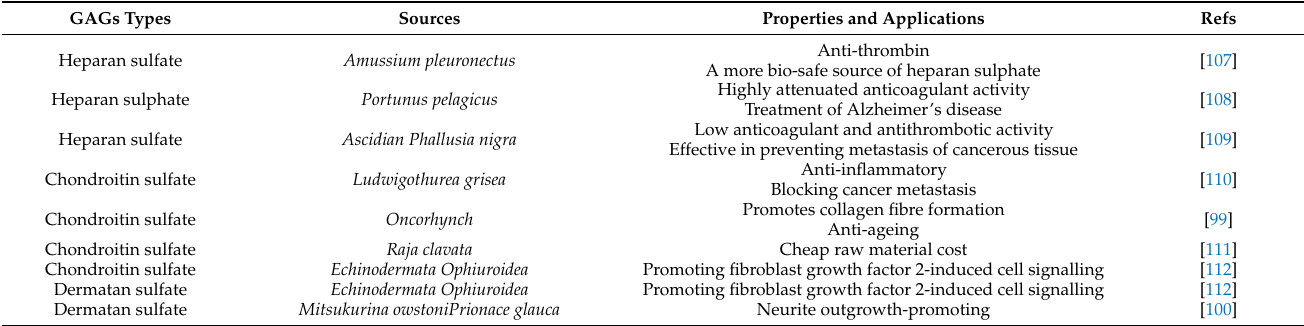
Table 4. Sources and characteristics of representative marine GAGs found in recent